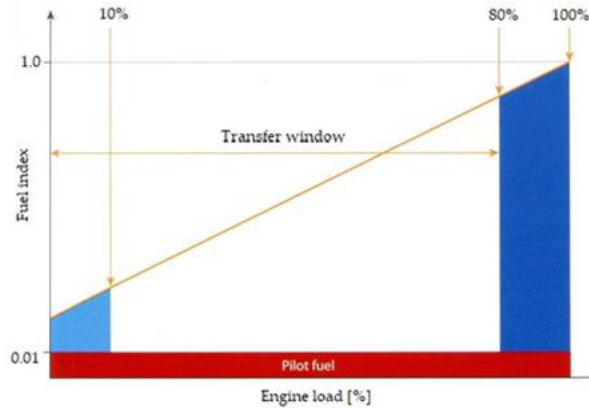
Fig. 7. The various operating conditions known as “modes” for dual-fuel engines, where horizontal is the engine load between 0–100%, and vertical is the fuel-index from 0 to 1 or 0 to 100% (reproduced from [11])